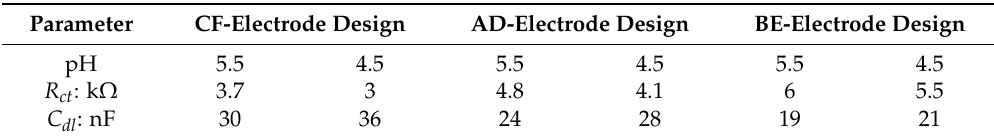
Table 1. Fitting parameters for the circuit model of three electrode configurations at different pH